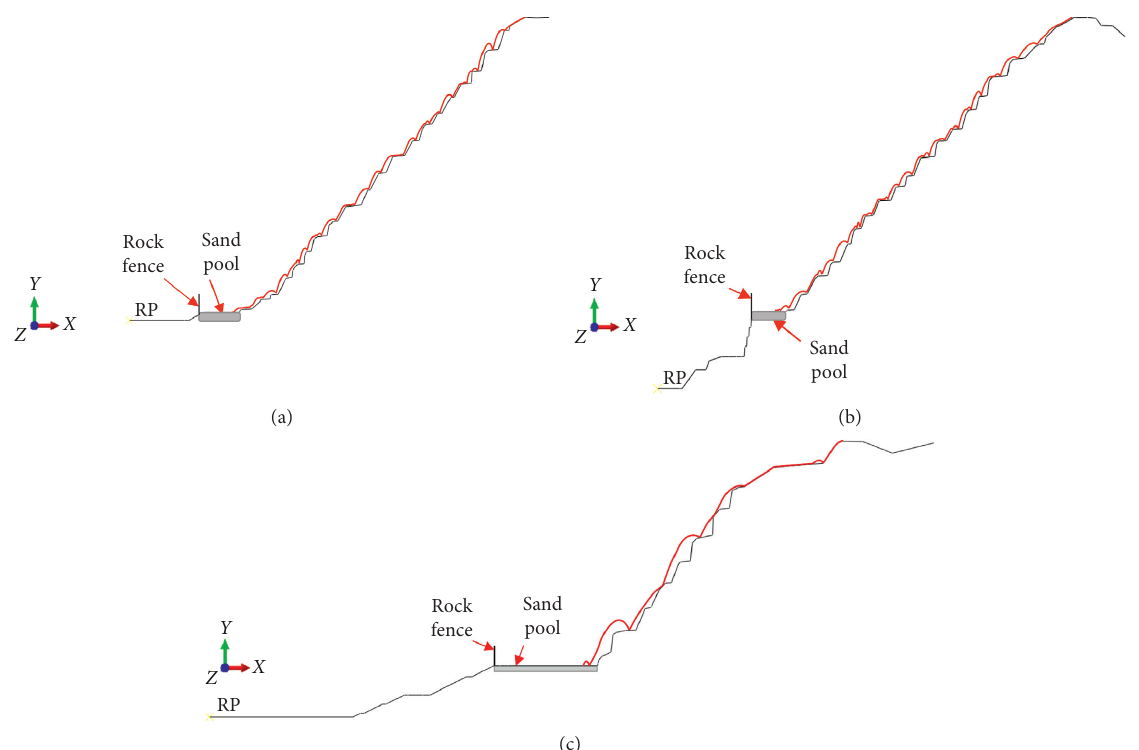
Figure 7: Results of rock-dropping simulations with sand pool: (a) section 1; (b) section 2; (c) section